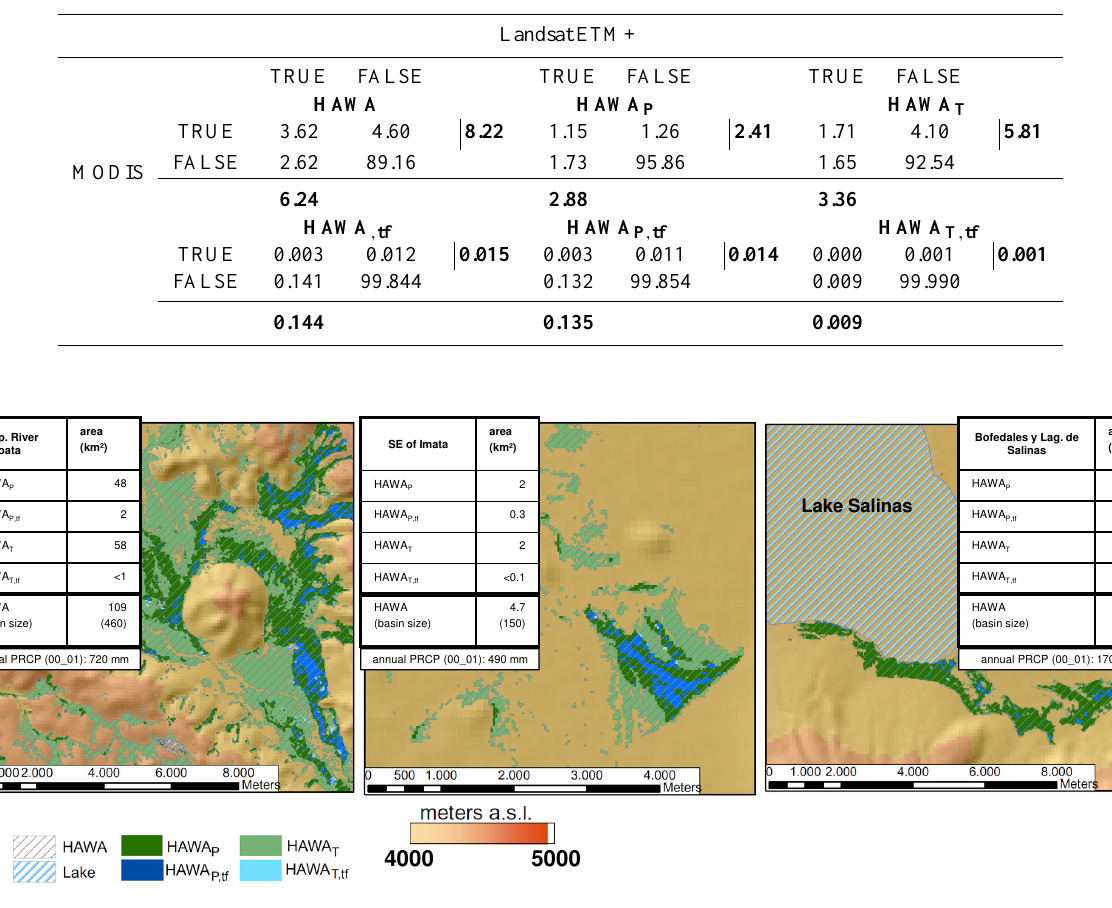
Fig. 8. Subsets of Landsat ETM+ based HAWA mapping result (only HAWA). Left: Upper River Coater, centre: South East of the village Imata, right: HAWA area of Ramsar Site Bofedales y Laguna de Salinas (Ramsar Site NO.: 1317). Numbers in attached tables indicate total cover of HAWA subtypes within corresponding basins (number top left of each table) and annual precipitation rates (annual